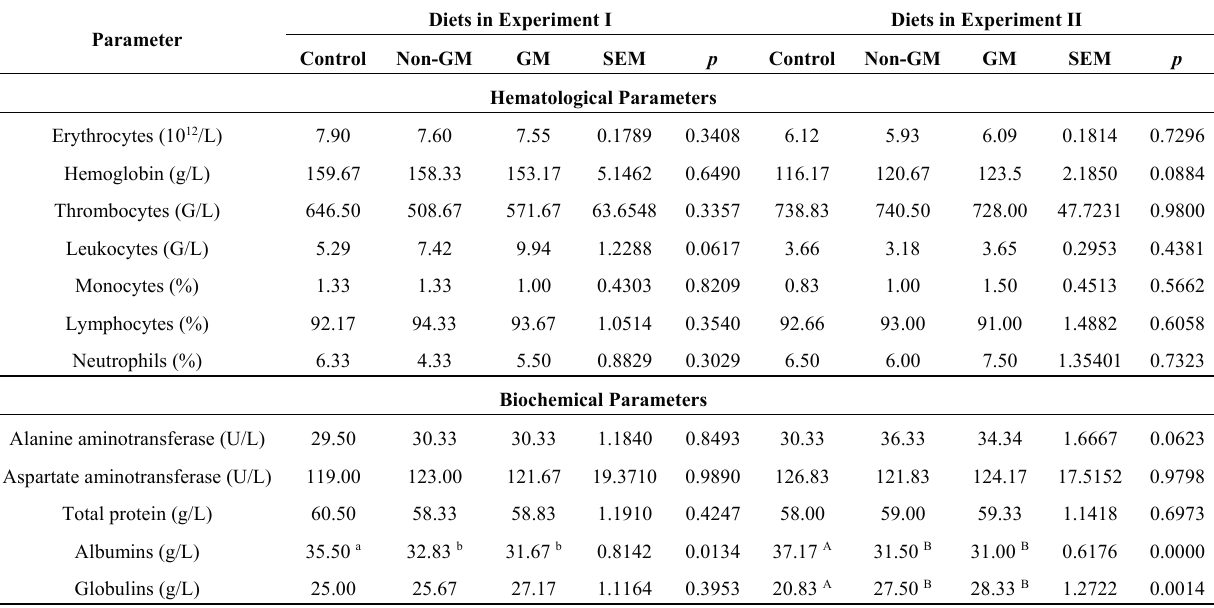
Table 2. Hematological and biochemical blood parameters.